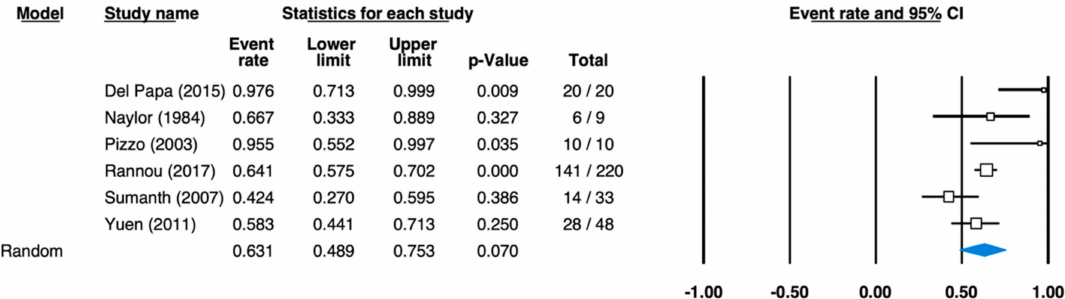
Figure 4. Forest plot for the pooled effect estimates of prevalence in scleroderma—lip symptoms (heterogeneity: I- squared = 78.905; tau-squared = 0.375, p = 0.003).